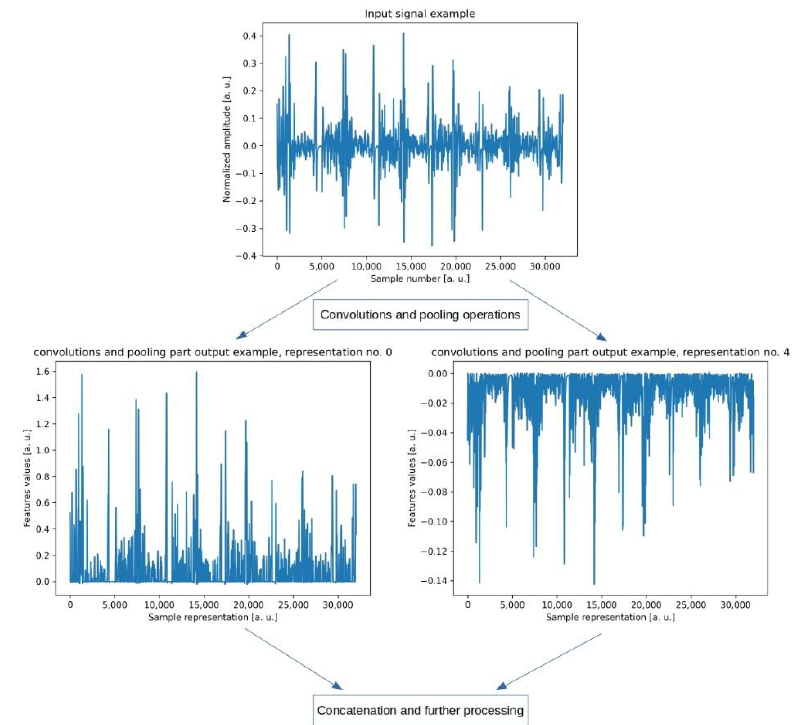
Figure 5. A diagram of the preprocessing step of our model. One can notice that convolutions and pooling operations generate a set of signal representations because each single convolutional layer consists of multiple filters which results in multiple output. Signal representations are shorter than the signal itself because of the pooling layers which discard some processed samples.